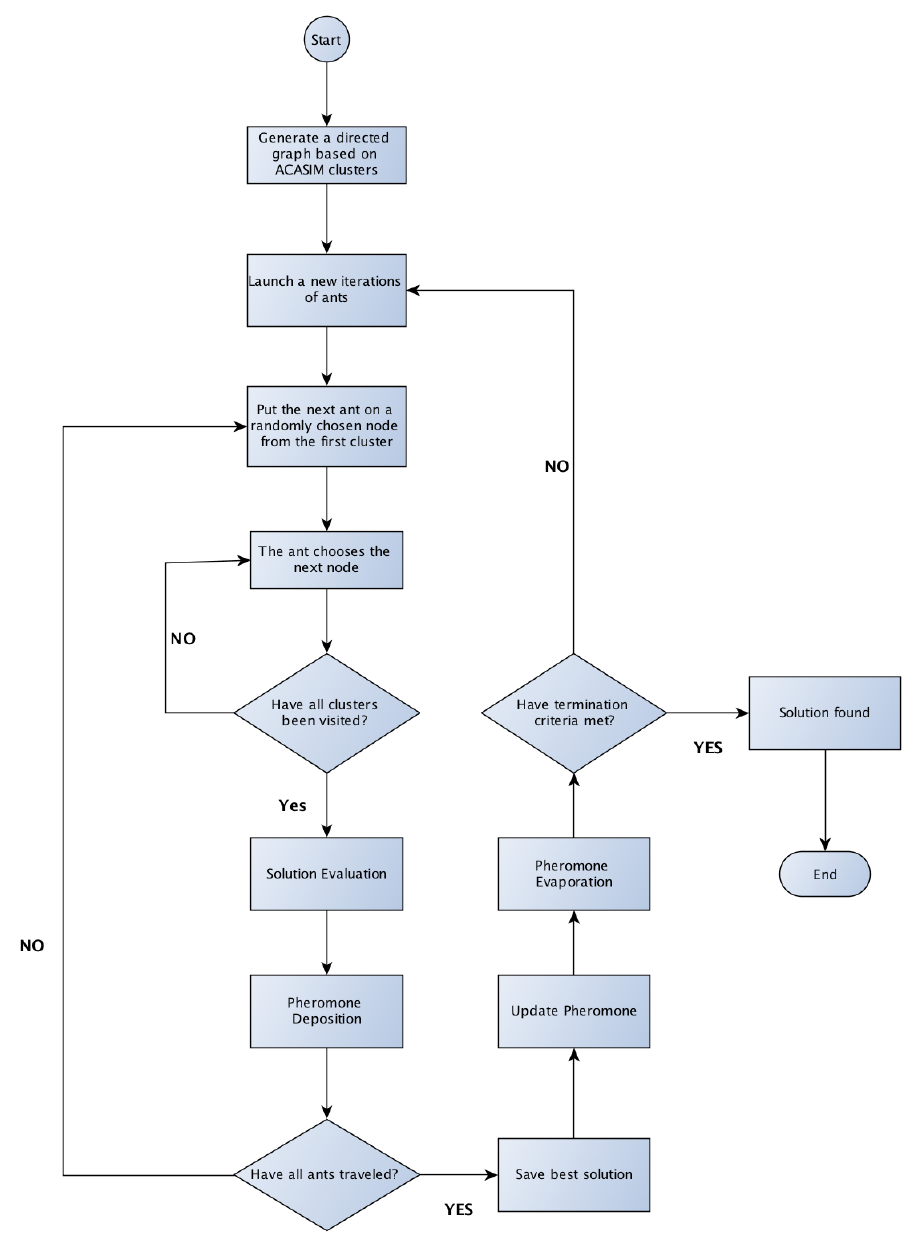
Figure 7. ACOSIM’s